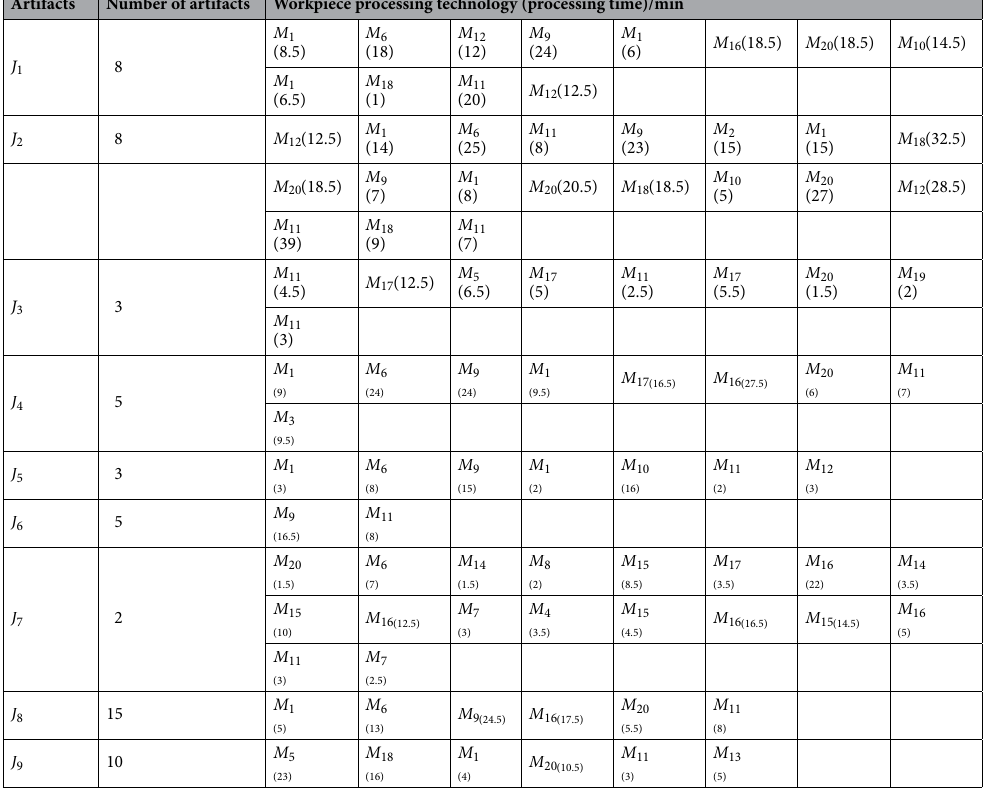
Table 2. Workpiece manufacturing data of workshop.